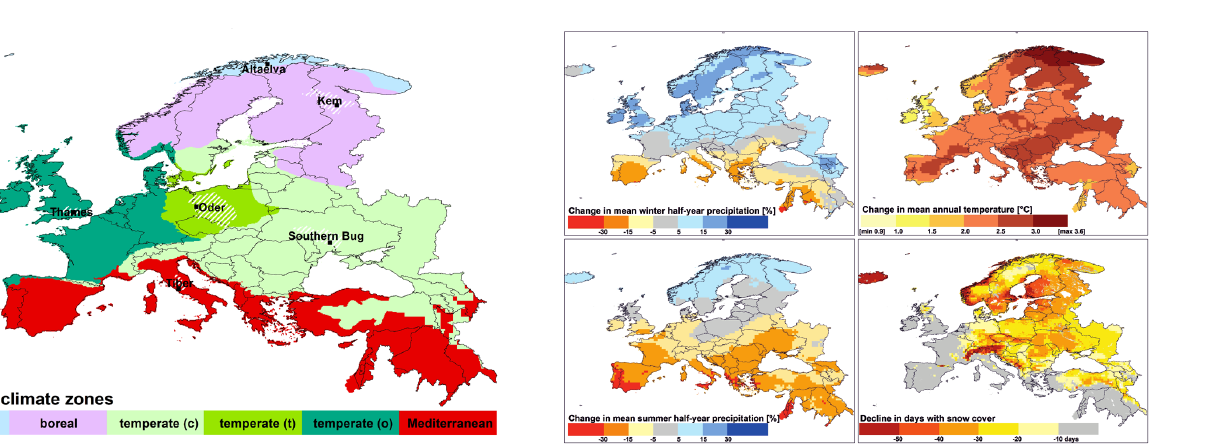
Fig. 2. Climatic changes in the 2050s featuring changes from the baseline in mean precipitation of winter and summer half-year (left), mean annual temperature and snow cover duration (right). The maps represent the ensemble mean of the three climate projec-